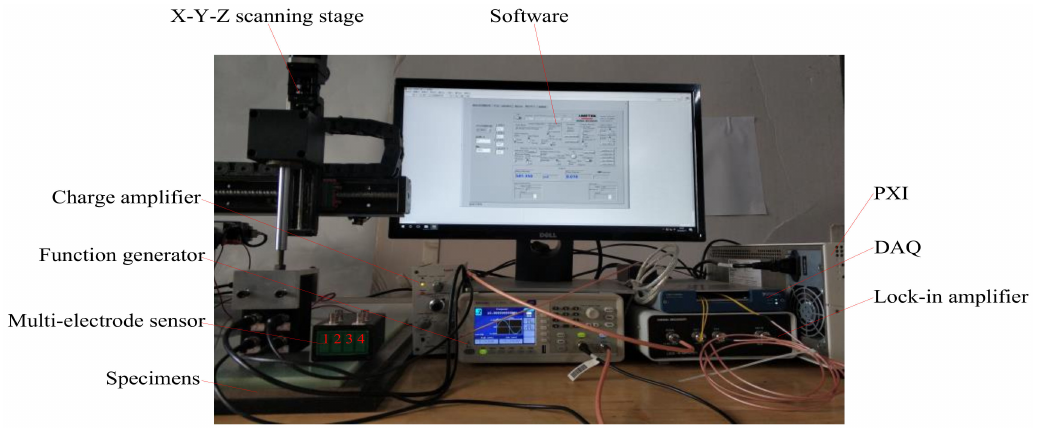
Figure 7. Setup of basic experimental